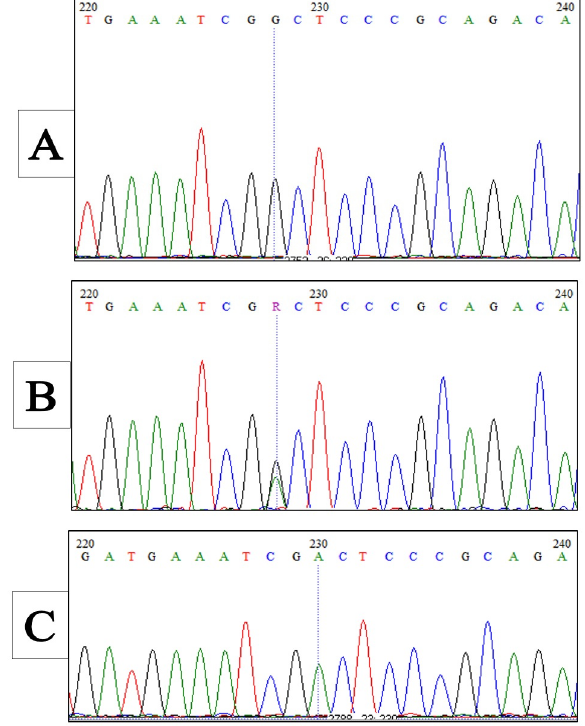
Figure 3. Electropherograms for rs1801133 validation: ( A ) homozygous G; ( B ) heterozygous G/A; ( C ) homozygous A.